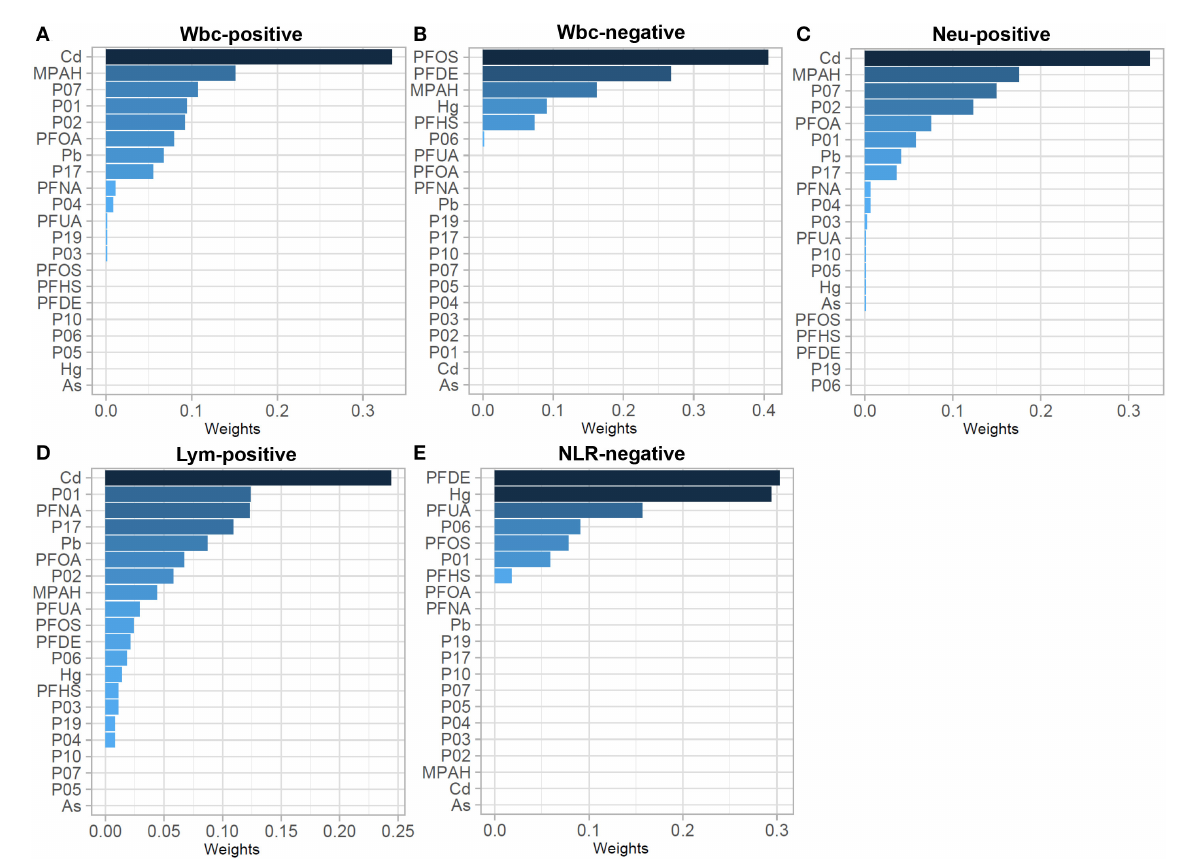
FIGURE2 WQSR weights in the WQSR model between immunoinflammatory biomarkers and WQSR index of total 21 environmental chemical mixtures. (A) Weights in WQSR index in the models of Wbc-positive. (B) Weights in WQSR index in the models of Wbc-negative. (C) Weights in WQSR index in the models of Neu-positive. (D) Weights in WQSR index in the models of Lym-positive. (E) Weights in WQSR index in the models of